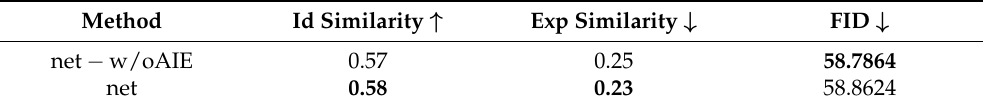
Table 1. Quantitative analysis of the superiority of the adaptive identity editing module. Bold represents the optimal